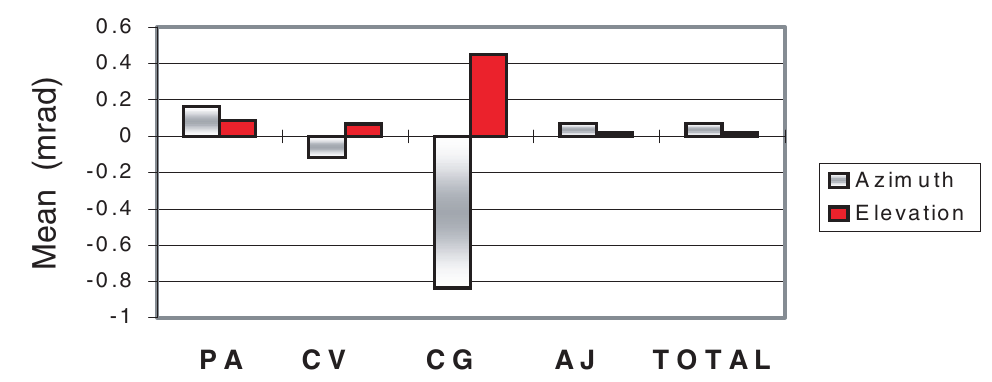
Fig. 3. M242 barrel serial number 273 for the 25-mm chain gun.